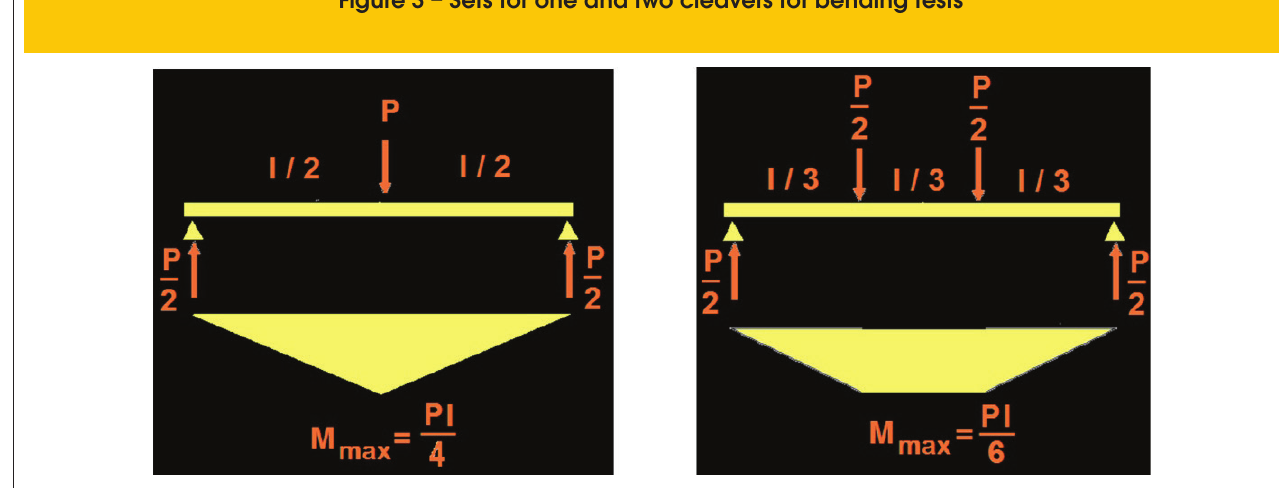
Figure 3 – Sets for one and two cleavers for bending tests